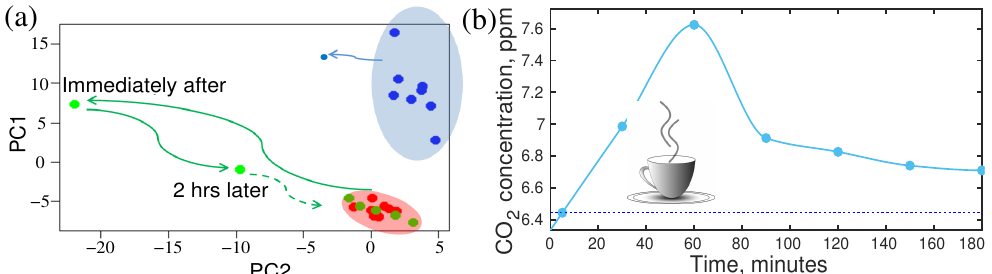
Figure 3. Effect of coffee for rare and moderate coffee drinkers. ( a ) The shift of the steady state point in PCA representation and its return for the rare coffee drinker (green) and a moderate drinker (blue). ( b ) The dynamics of CO 2 concentration of a rare coffee drinker in time. Note that the effect reaches its maximum 1 h after the intake and lasts up to 7 h (evaluation).